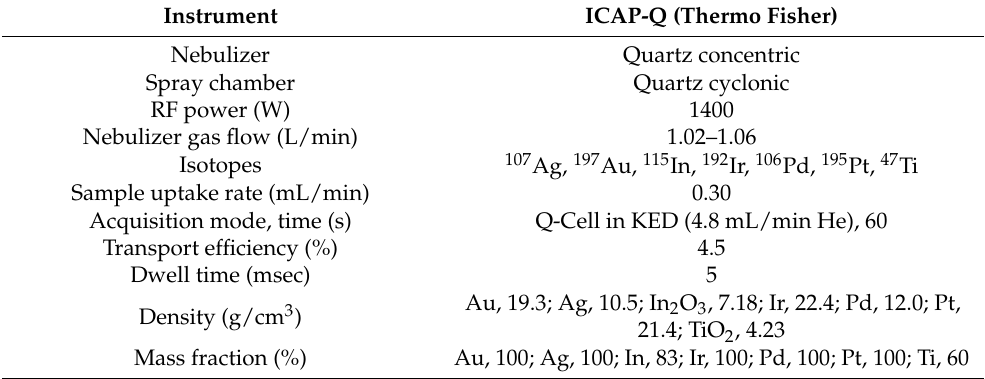
Table 1. Single Particle-Inductively Coupled Plasma-Mass Spectrometry (SP-ICP-MS) method